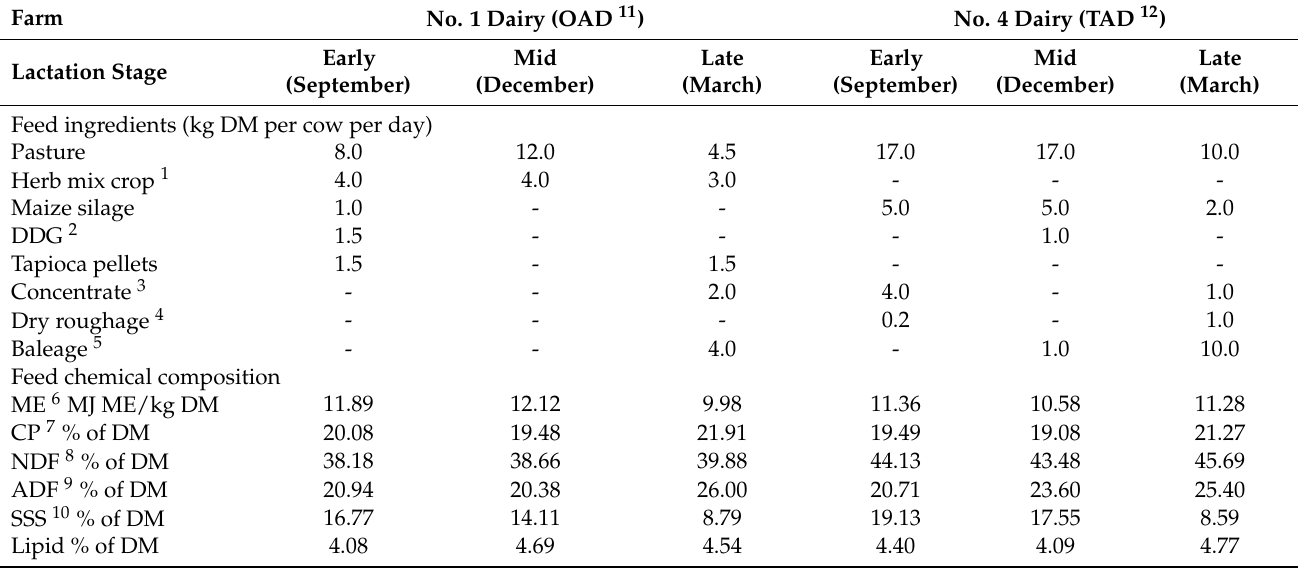
Table 1. Dietary feed composition and chemical composition of the feed offered at No. 1 Dairy and No. 4 Dairy during the sampling season in early lactation, mid-lactation, and late lactation in